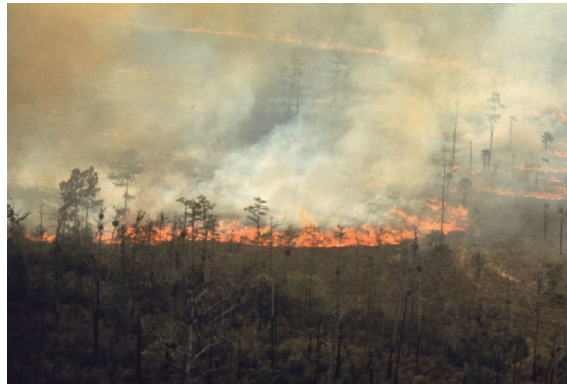
Figure 1. Fire in the Everglades National Park, USA (photo- graph: Flip